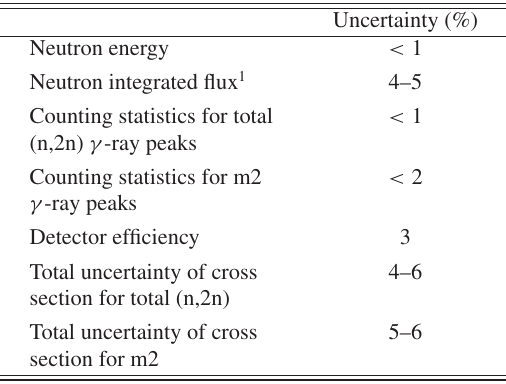
Figure 4. Experimental values of the present work at 17.1 and 20.9MeV incident neutron energy, along with EXFOR data [19] from literature and theoretical calculations for: (a) the population of the second isomeric state of 196 Au (m2), (b) the population of the ground, first and second isomeric states of 196 Au. Table 2. Compilation of